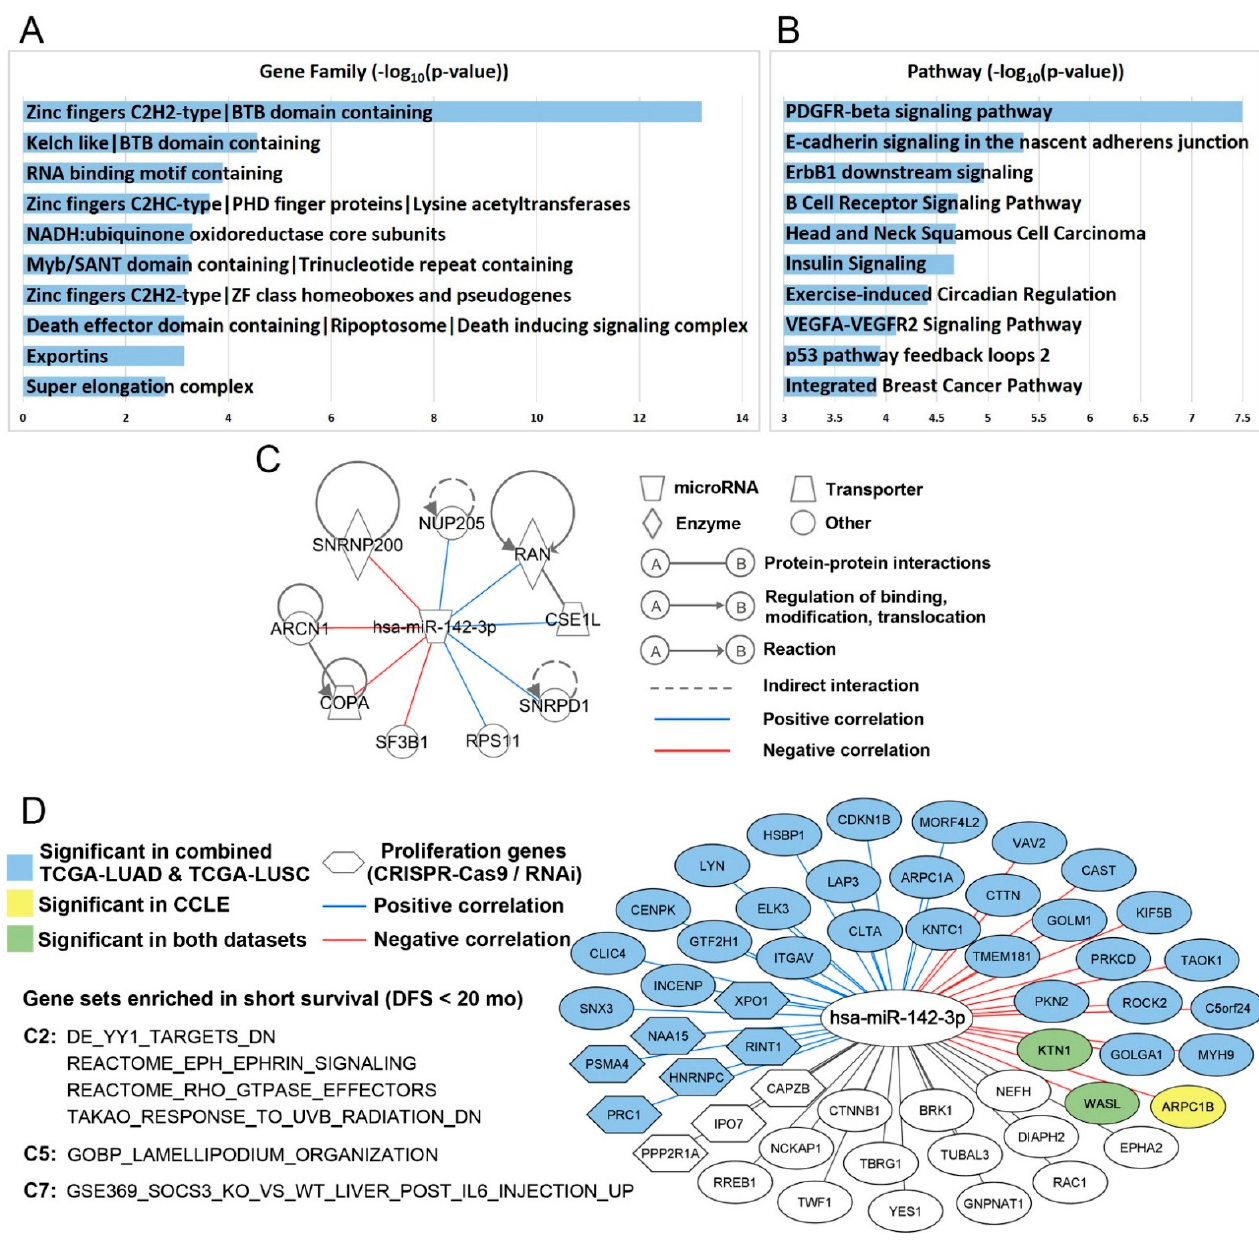
Figure 5. Hsa-miR-142-3p-mediated pathways and functional networks in NSCLC. Top 10 ranked gene families ( A ) and pathways ( B ) of hsa-miR-142-3p target genes in ToppGene functional enrichment analysis. ( C ) Hsa-miR-142-3p target genes with a significant dependency score in 100% of the tested NSCLC cell lines in both CRISPR-Cas9 ( n = 78) and RNAi ( n = 92). Detailed information is included in File S2, “dependency score” (Supplementary Materials). The experimentally confirmed interactions from IPA were also shown in the plot. The correlation between hsa-miR-142-3p and the target genes was computed in the combined TCGA-LUAD and TCGA-LUSC data. ( D ) Hsa-miR-142-3p target genes that were significantly ( p < 0.05) enriched in three NSCLC patient cohorts with short-term survival in GSEA in C2, C5, and C7 data- bases. The colored nodes and edges showed the significant ( p < 0.05) correlation of hsa-miR-142-3p and the target genes in TCGA and CCLE.